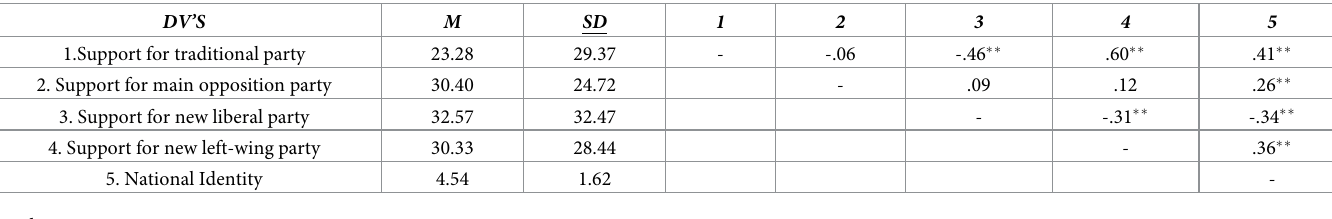
Table 1. Means, standard deviations and correlations for support for the parties and national identity. DV’S